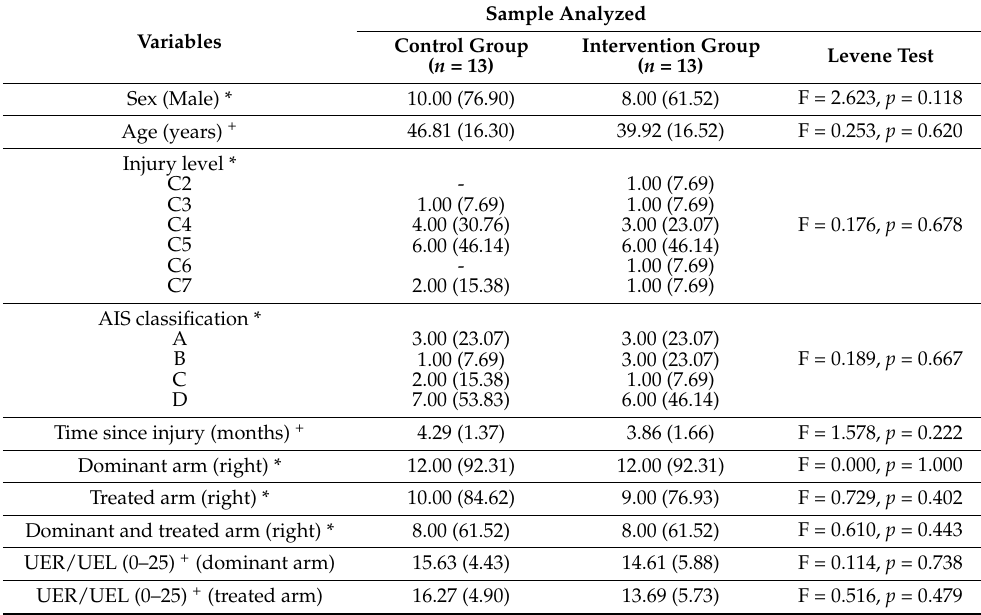
Table 1. Demographic and functional characteristics of the sample